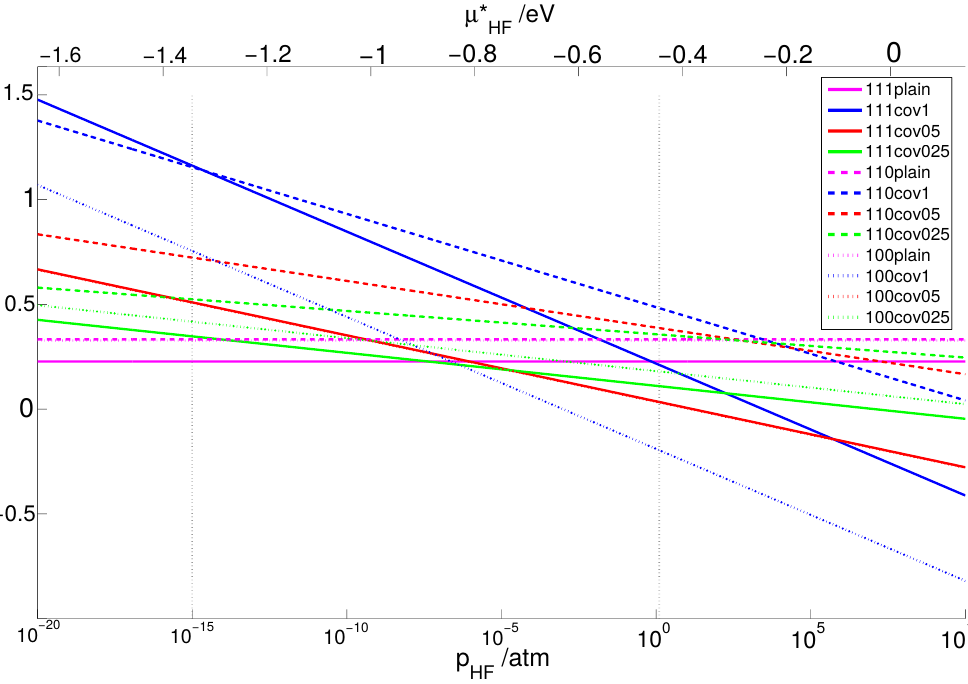
Figure 2. Variation of the surface energy as a function of the pressure of HF for the three low index surfaces of CaF 2 at 300